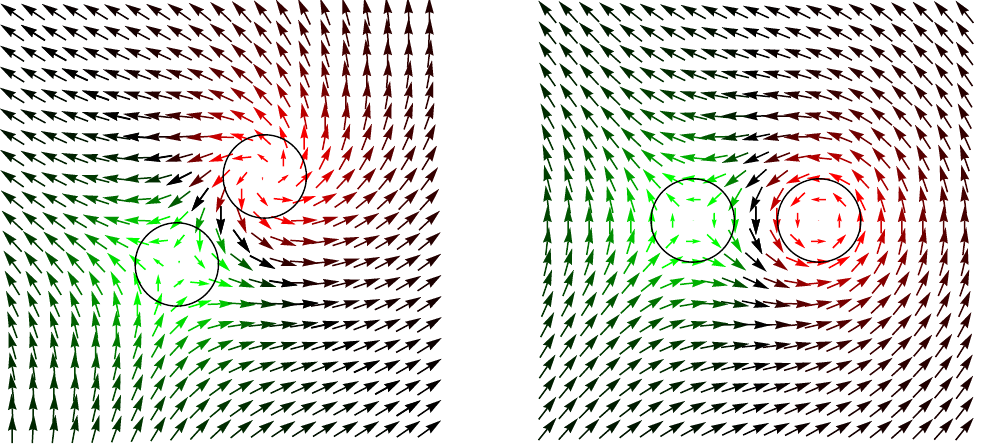
Figure 5. Two schematic diagrams for a rotating dipole which differ by rotations of 45 ◦ and 90 ◦ from Figure 3b. The imaginary part of the SU(2)-field are indicated by arrows. The visibility of the positions of the two charges is enhanced by surrounding circles. Red/green/black arrows indicate q 0 > 0/ q 0 < 0/ q 0 =